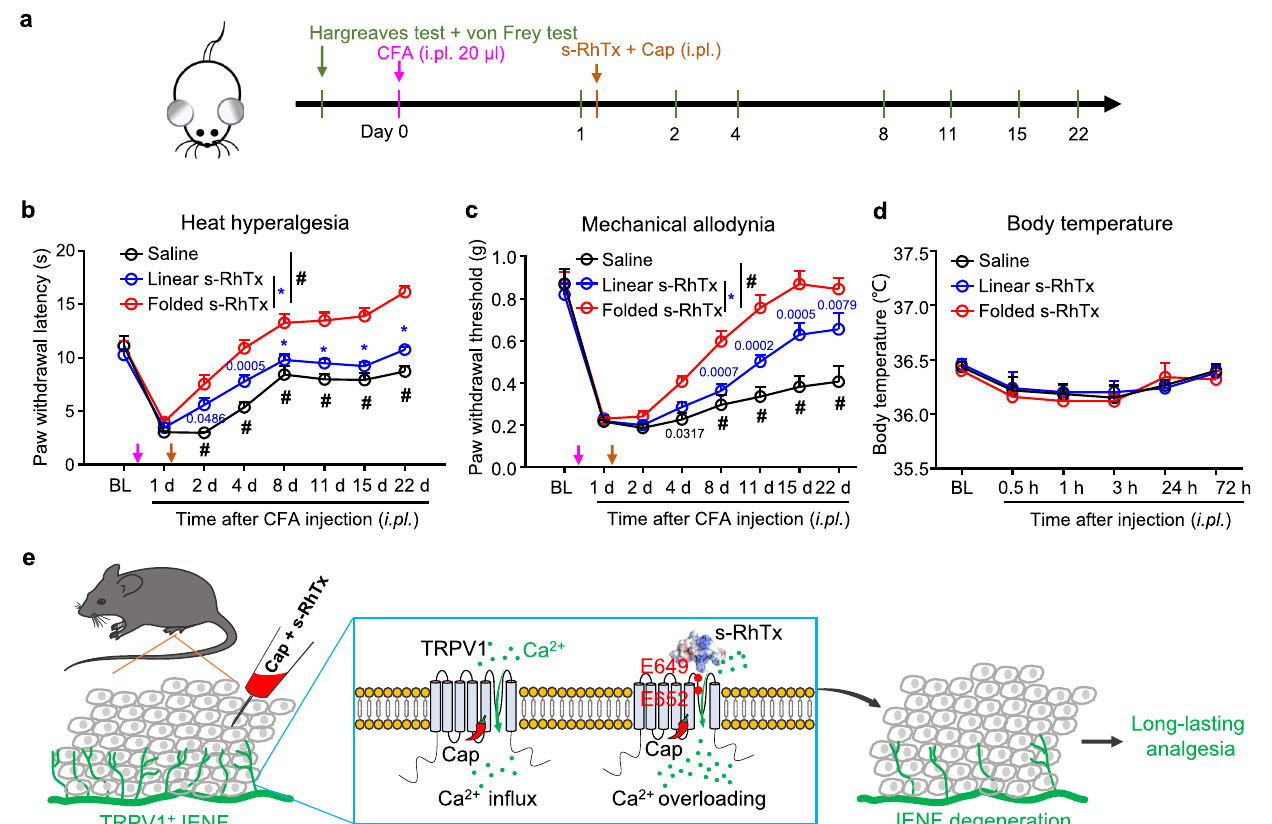
Fig. 7 | s-RhTx relieved CFA-induced mechanical allodynia and heat hyper- algesiainchronicin fl ammatorypainmodelmice.a Schematicillustrationofthe procedures to establish CFA-induced chronic in fl ammatory pain model and experimental time-line. 20 μ l of CFA was injected fi rst to induce a chronic pain model.2 μ goffoldeds-RhTxorlinears-RhTxwithcapsaicin(200ng)in20 μ